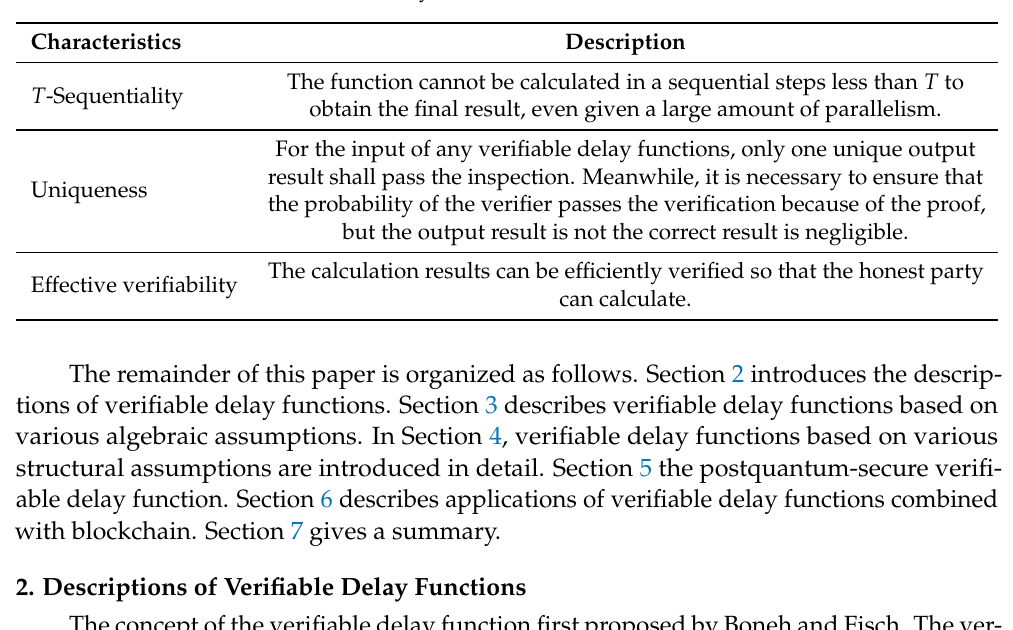
Table 1. Characteristics of verifiable delay functions.